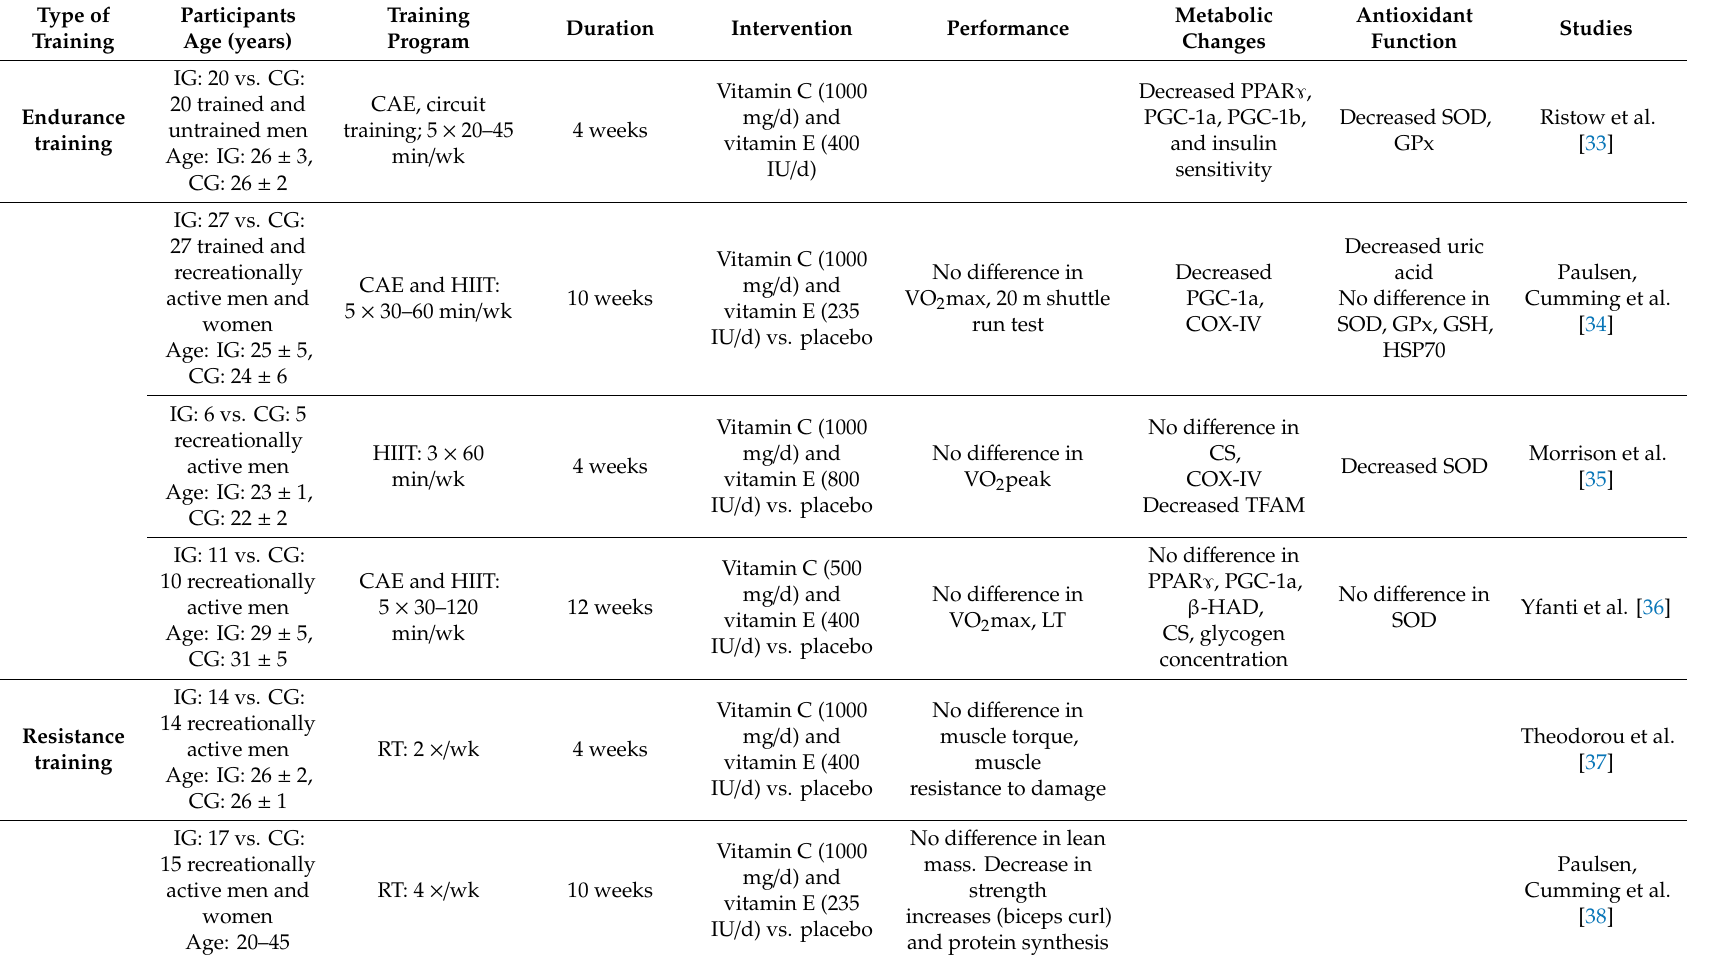
Table 2. Selected studies on the e ff ect of vitamin C and vitamin E administration to subjects performing physical activity. Type